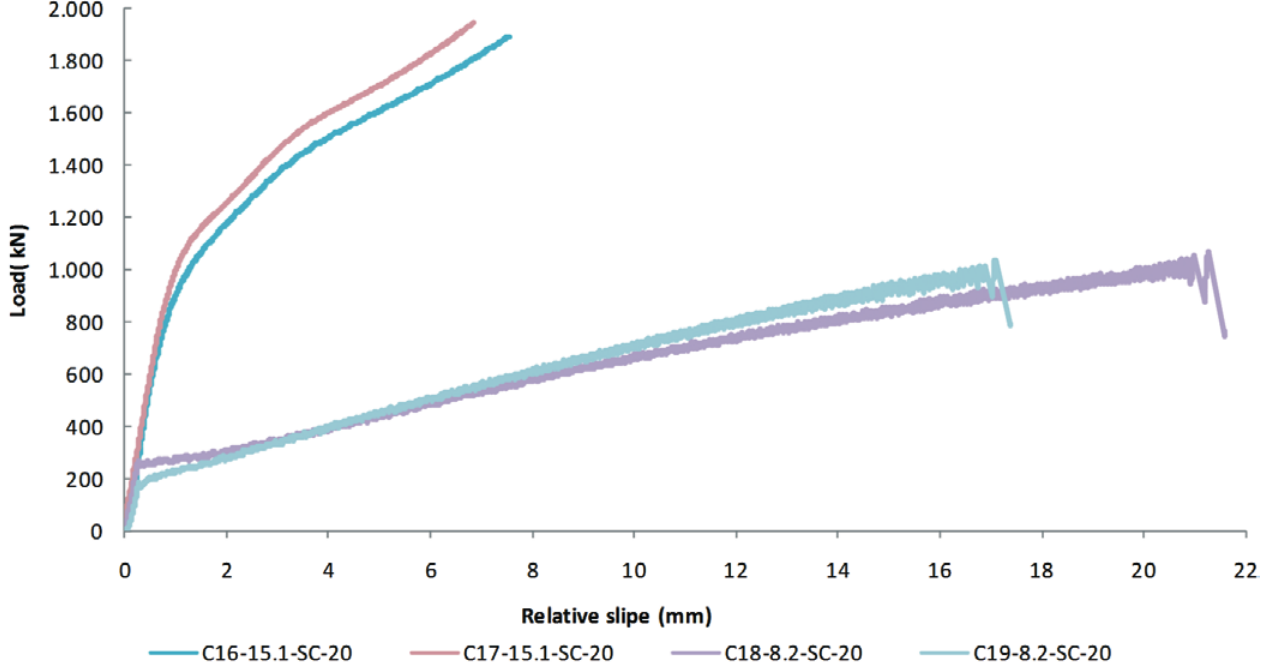
Curves load versus relative displacement series B